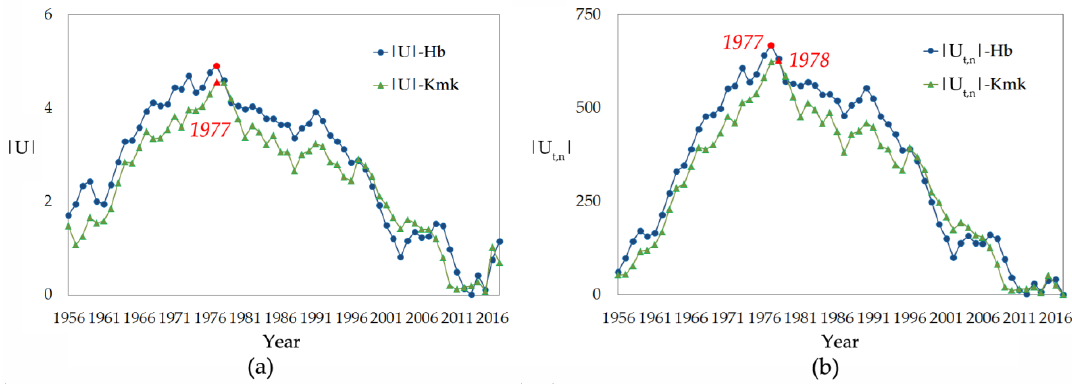
Figure 2. Abrupt change detection for annual runoff series during 1956–2017 of two tributaries at Houbi (Hb) and Kuangmenkou (Kmk) sections, with maximum values of | U | in MRS test and | Ut , n | in Pettitt test both appearing in 1977 at Hb section, as for Kmk section, 1977 and 1978 showed similar extreme values in both tests, though with different results. ( a ) MRS test statistic | U |, based on formula (1); ( b ) Pettitt test statistic | Ut , n |, based on formula (2). Table 2. Monotonic trend detection for annual runoff subseries during pre-change and post-change periods.